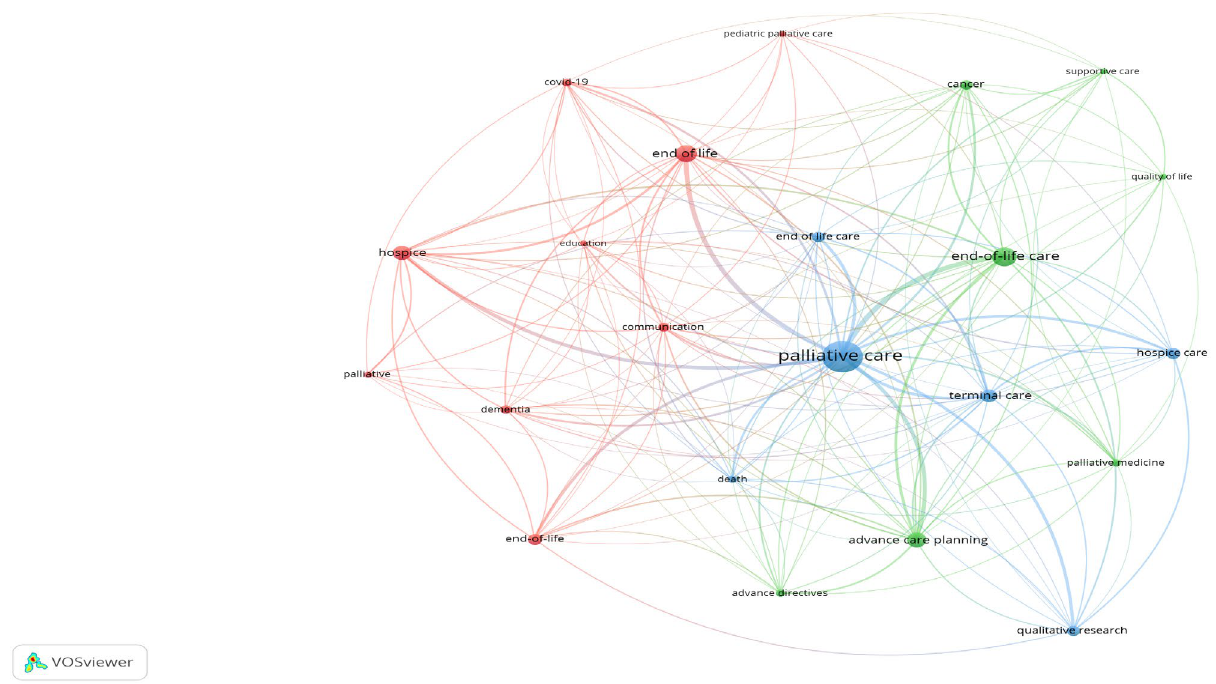
Figure 3. Network visualization map of the keywords’ co-occurrence. The science mapping of the 20 most active keywords, with at least 10 occurrences, generated three clusters, with each representing the domain that was most relevant: these included palliative care, end of life care, and advance care planning. The statistical details of the most active keywords have been presented in Table